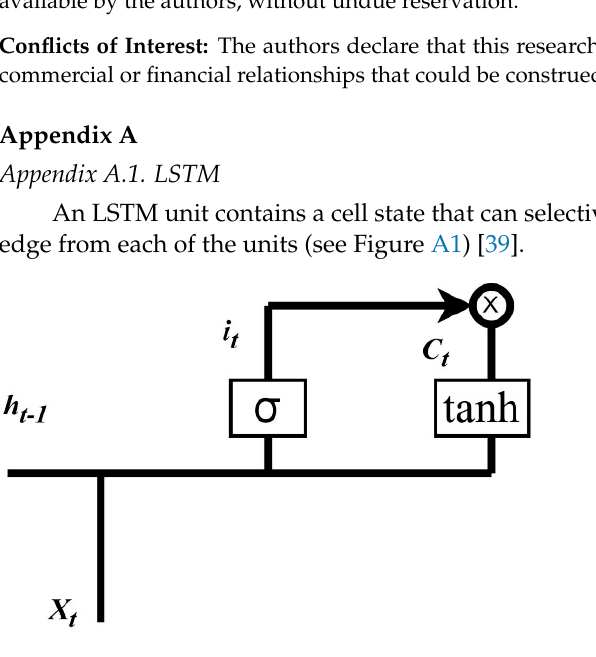
Figure A1. An LSTM unit.